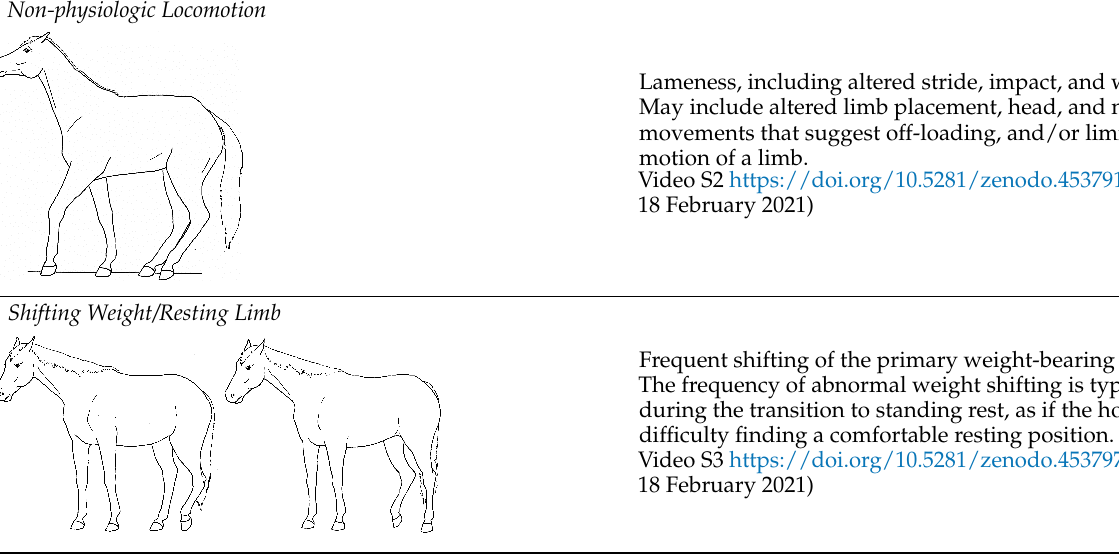
Table 1. Posture and weight-bearing.